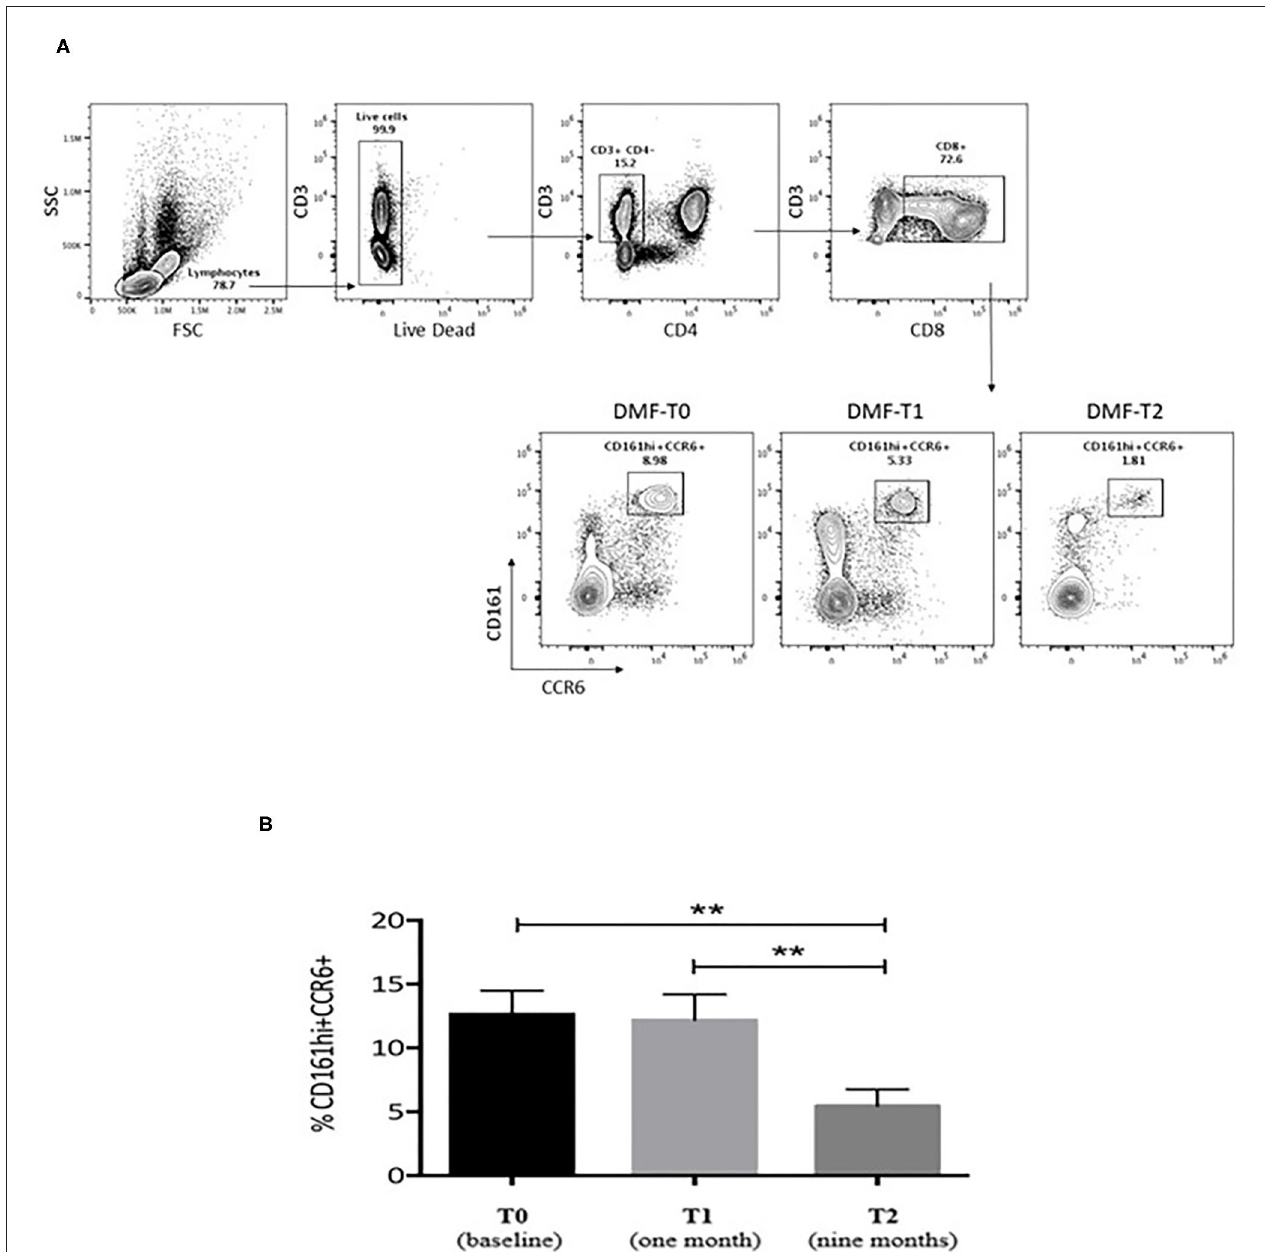
FIGURE 2 | (A) Representative plots showing the frequencies of subpopulations of CD8T cells (CD161hi CCR6 + ) in an MS patient during dimethylfumarate (DMF) treatment. Freshly isolated PBMCs were stained with CD3, CD8, CD4, CD161, and CCR6. For this study, we followed 23 patients undergoing treatment with DMF at different time points (3 and 9 months) after initiation of therapy to evaluate the in vivo impact of DMF on CD8T cells in MS. Numbers indicate percent of cells in each quadrant. (B) Cumulative data for the frequencies of CD8 + CD161hiCCR6 + T cells from the PBMCs of untreated MS patients at baseline (black bar, n = 23), T1 (1 month), and T2 (9 months of therapy; gray bars, n = 23). The T-cell subset dropped significantly at T2 compared to T0 and T1. Statistical comparisons were performed by ANOVA and Dunnett’s multiple comparisons test. Significant values: ** p <